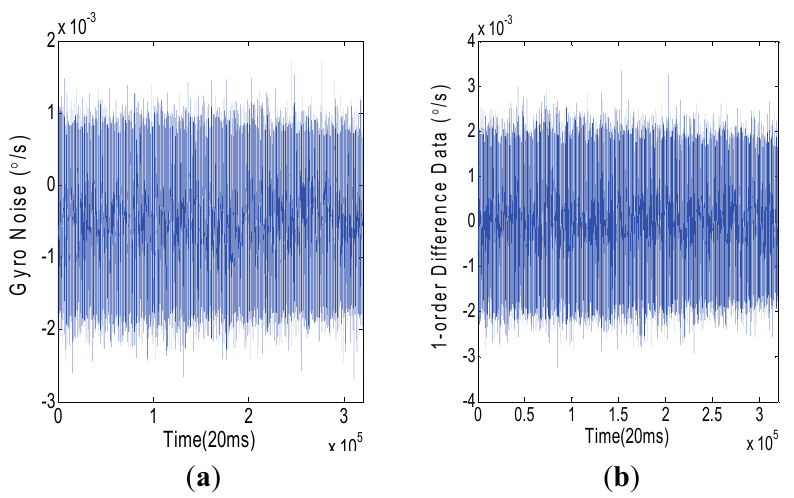
Figure 2. Random noise of VG951 FOG. ( a ) Original data (°/s). ( b ) First-order difference of random noise.